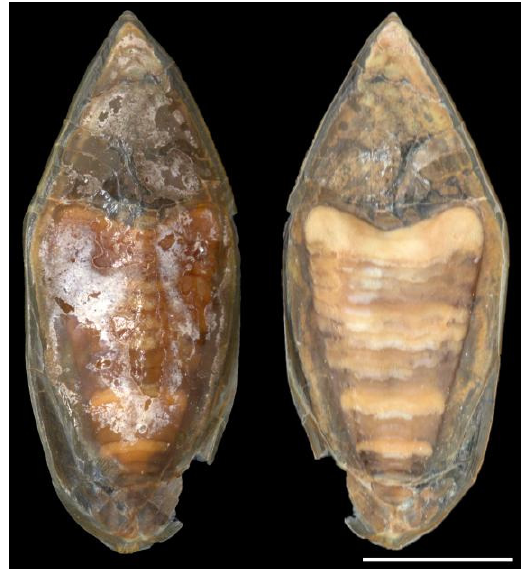
Figure 22. Cuttlebone of male Sepia typica (SAIAB 211602, ML 19 mm) in dorsal (left) and ventral (right) aspects. Scale bar 10 mm.